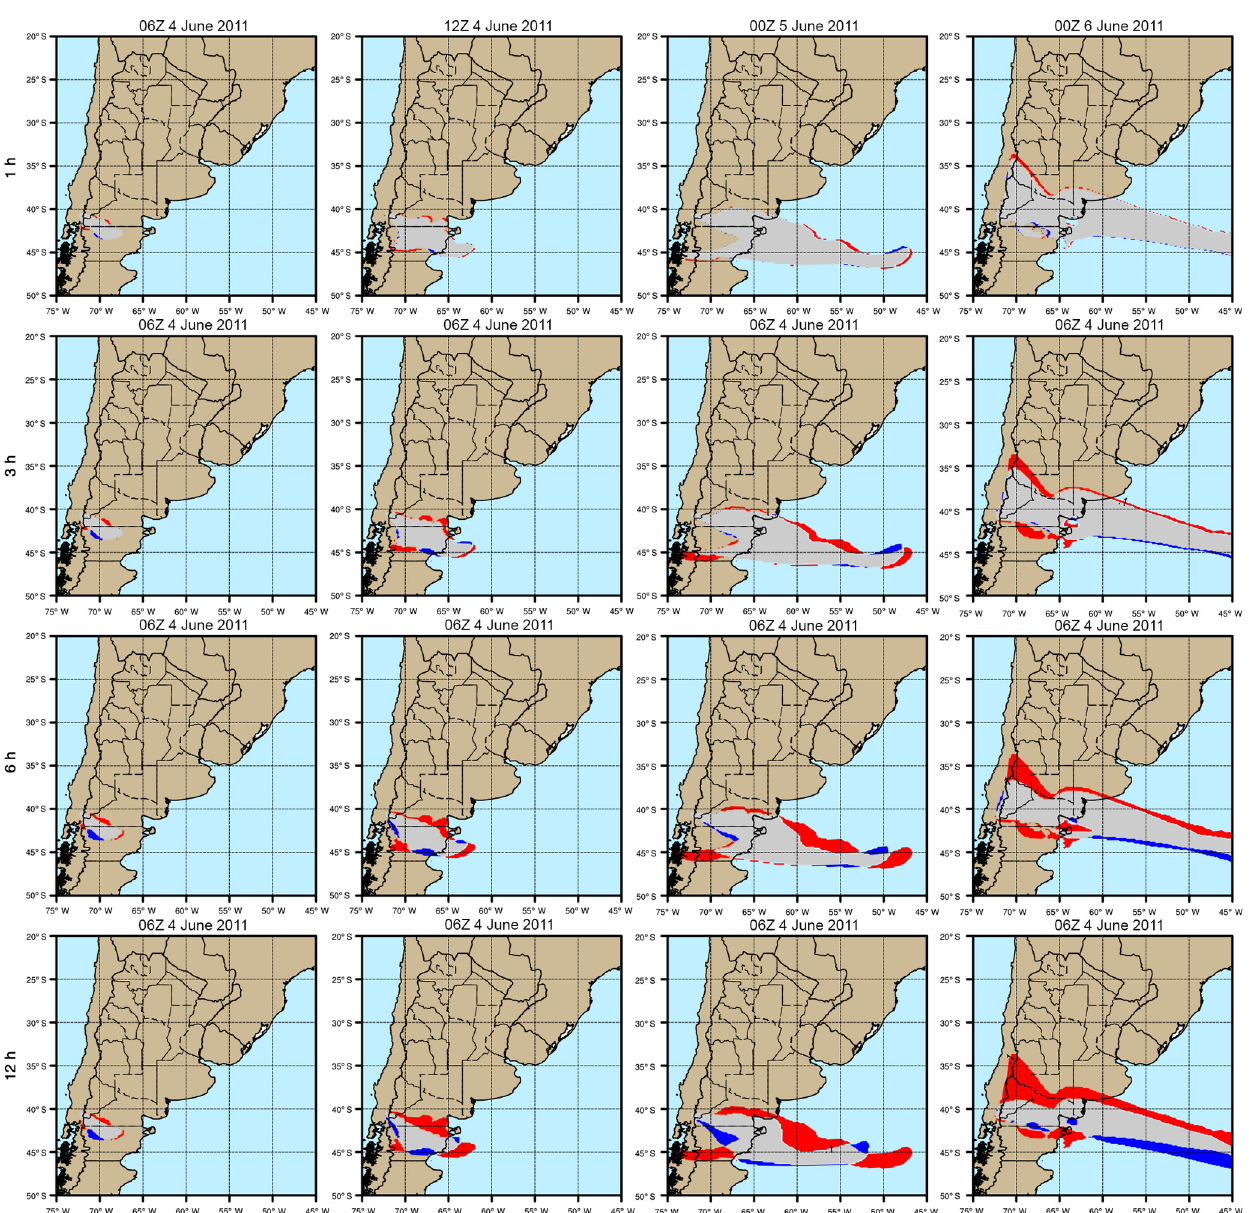
Figure 13. Qualitative offline vs. online forecast comparison for 1h (row 1), 3h (row 2), 6h (row 3), and 12h (row 4) coupling intervals. Gridded evaluation is performed following the criteria presented in the contingency Table 2. Hit (grey), missed (red), and false alarm (blue) predictions are shown for the 2011 Cordón Caulle application over